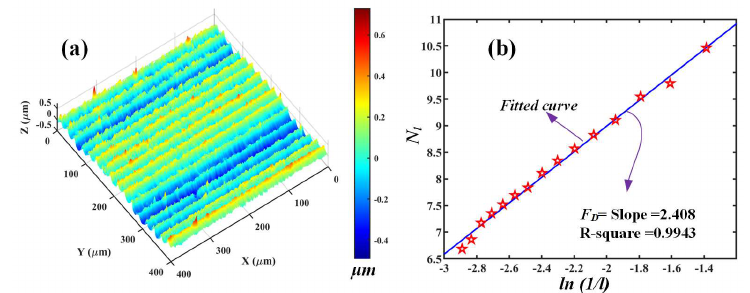
Figure 2. Calculating the fractal dimension (FD) based on the Box-counting method: ( a ) a sample KDP surface produced by micro-milling; ( b ) the calculated fractal dimension of the micro-milled surface in ( a ).